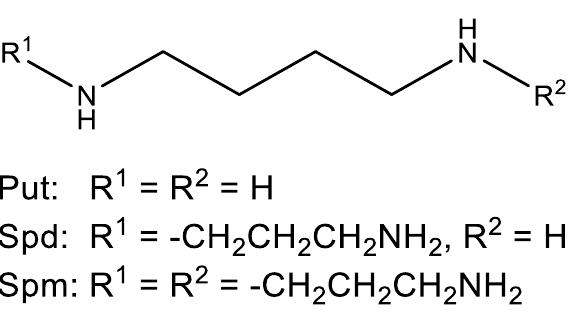
Figure 1. Chemical structures of the main polyamines.